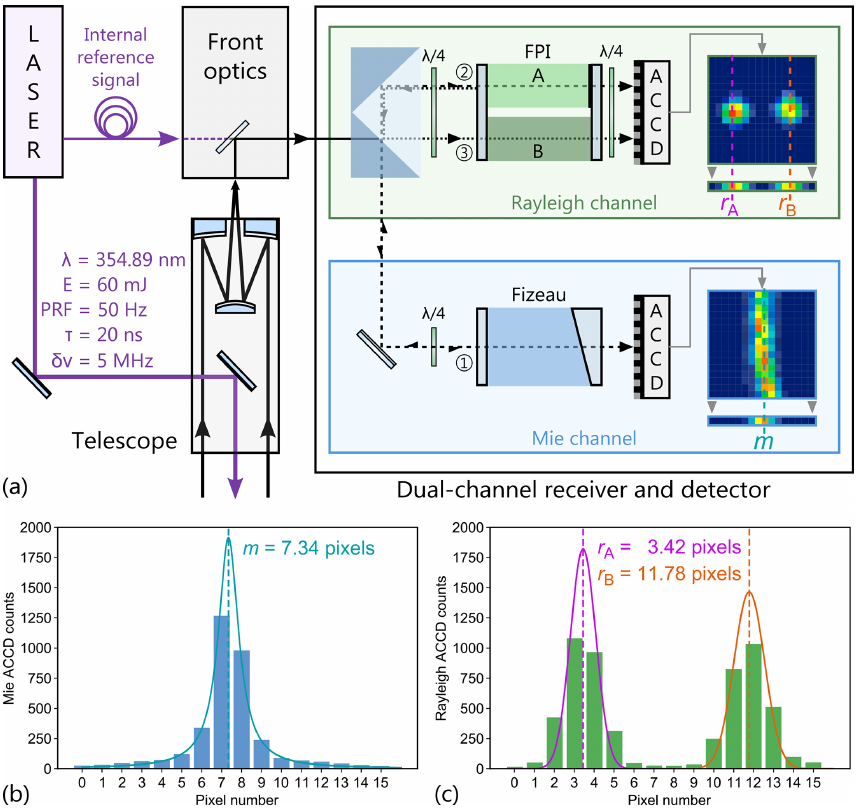
Figure 3. (a) Simplified schematic of the A2D comprising a frequency-stabilized UV laser transmitter, a Cassegrain telescope, front optics, and a dual-channel receiver. Note: FPI – Fabry–Pérot interferometer; PRF – pulse repetition frequency; ACCD accumulation charge-coupled device. (b) Exemplary signal distribution measured with the Mie ACCD detector (blue bars) and Lorentzian fit of the signals transmitted through the Fizeau interferometer (FI) for determining the Mie fringe centroid position m . (c) Exemplary signal distribution measured with the Rayleigh ACCD detector (green bars) and Gaussian fits of the signals transmitted through the two FPIs (A – pink; B – orange) for determining the Rayleigh spot positions r A and r B